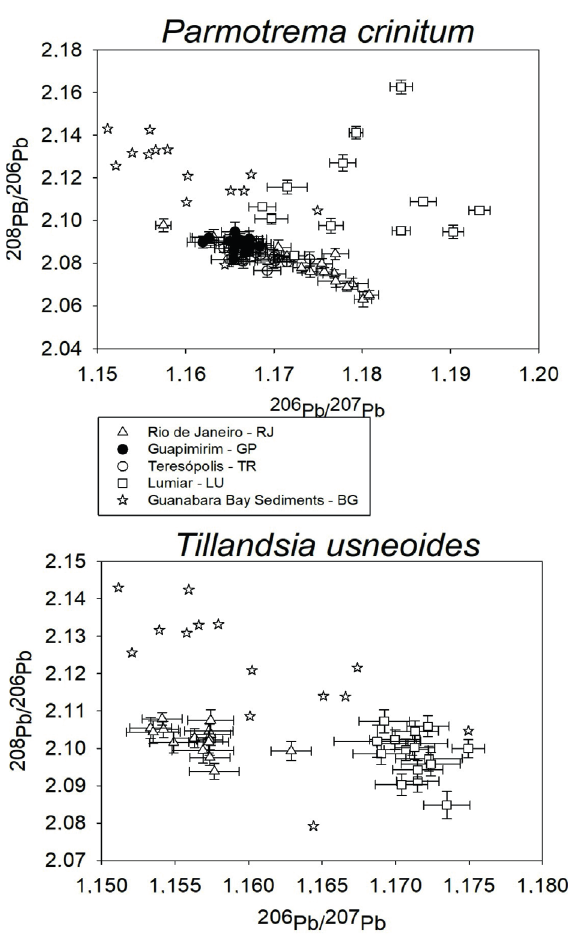
Figure 4 - Plot of lead isotope ratios ( 206 Pb/ 207 Pb vs. 208 Pb/ 206 Pb) for Parmotrema crinitum (Ach.) and Tillandsia usneoides (L.). Guanabara Bay sediments